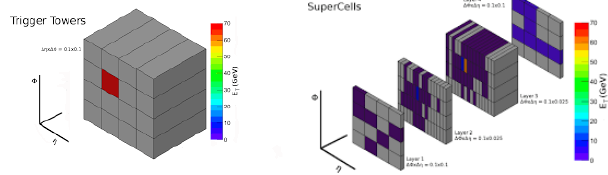
Figure 3: Diagrams showing the energy deposited by an electron with E T = 70 GeV as seen by a trigger tower (left) and by the equivalent SCs for a typical region in the EM calorimeter [7].